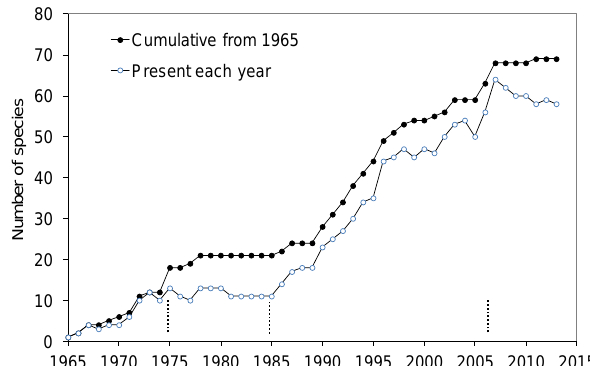
Figure 3. Surtsey colonization curve for vascular plants during the period 1965–2013. Vertical, dotted lines at bottom of diagram show divisions between the four main phases of